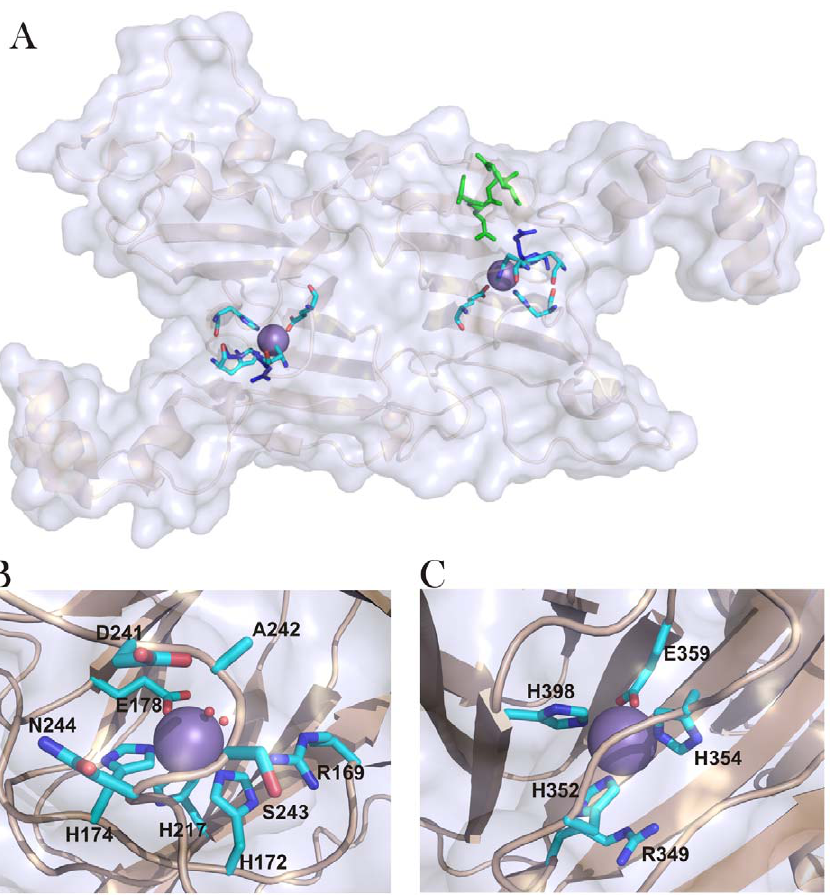
Figure 3. Manganese binding sites of the oxalate decarboxylase monomer and homology models of the manganese binding sites of CsOxOx. (A) OxDC (PDB ID 1UW8) [32] with manganese ions (purple), metal coordinating residues (atoms colored as follows: C, cyan; N, blue; O, red), conserved active site arginine residues (dark blue) and the N-terminal lid region (green) highlighted. (B) Homology model of the N-terminal CsOxOx Mn binding site metal coordinating residues and the DASN of the lid region. (C) Homology model of the C-terminal CsOxOx Mn binding site metal coordinating residues. The homology model of CsOxOx was constructed using its amino acid sequence and the experimentally solved structure of Bacillus subtilis OxDC (PDB ID 1UW8) using Swiss-Model (The Swiss Institute of Bioinformatics) [48,49,50]. Figure generated using Pymol (The